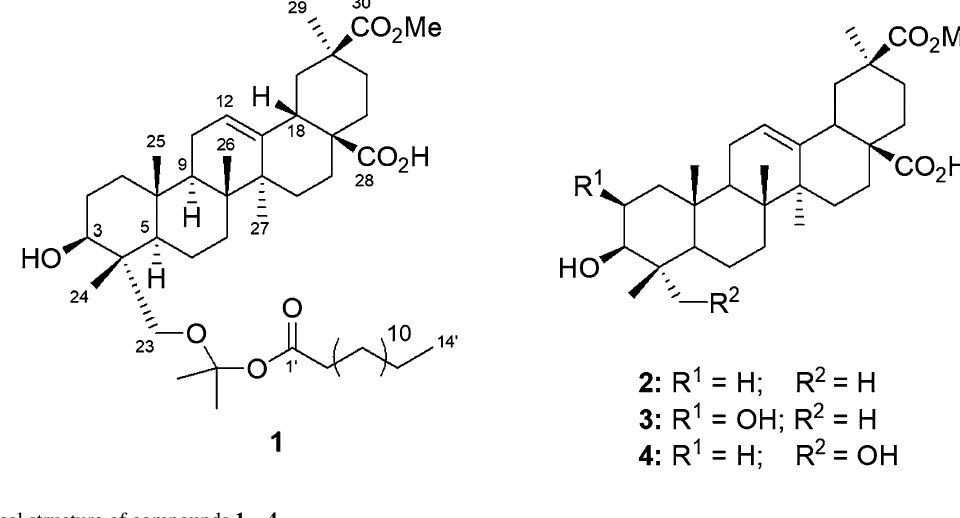
Fig. 1 Chemical structure of compounds 1 —